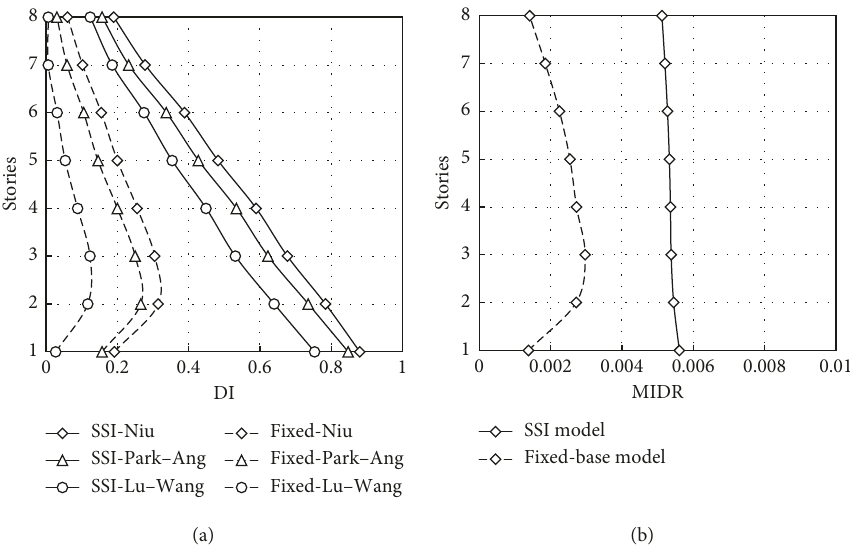
Figure 5: Distribution of damage at PGA of 0.1g with DPDMs (a) and the MIDR